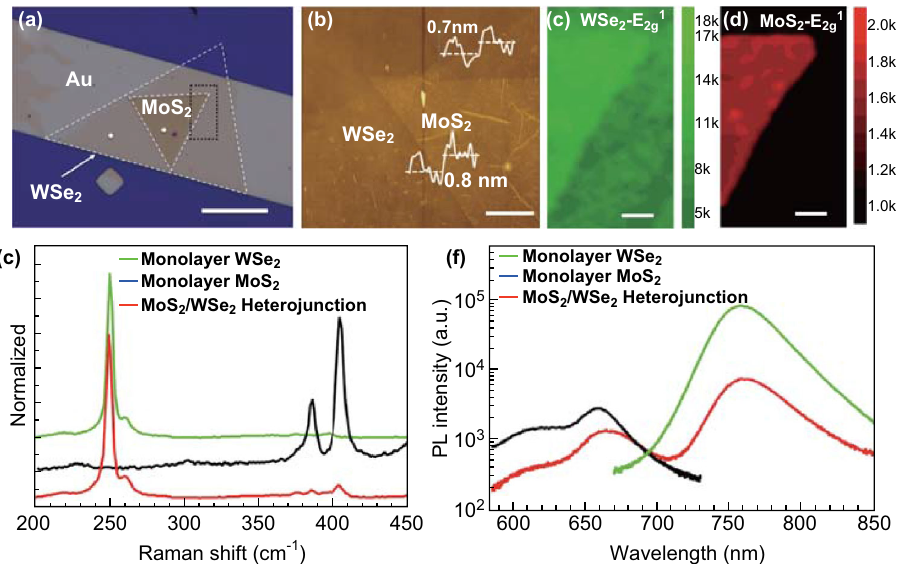
Fig. 2 a Optical image of monolayer MoS 2 /WSe 2 heterojunction (dashed in white triangle). The white dots marked in the optical image are the spots where the spectra are accumulated (scale bar is 30 m). b AFM scanning showing thickness of surface of MoS 2 /WSe 2 heterojunction and line scan profile (scale bar is 4 m). c , d Raman intensity map of the WSe 2 E 2g1 mode (green) and MoS 2 E 2g1 mode (red) in heterostructure, corresponding to black dashed square area in ( a ) (scale bar is 5 m). e , f Raman and PL spectra of monolayer MoS 2 (black line), WSe 2 (green line) and MoS 2 /WSe 2 heterojunction (red line). (Color figure